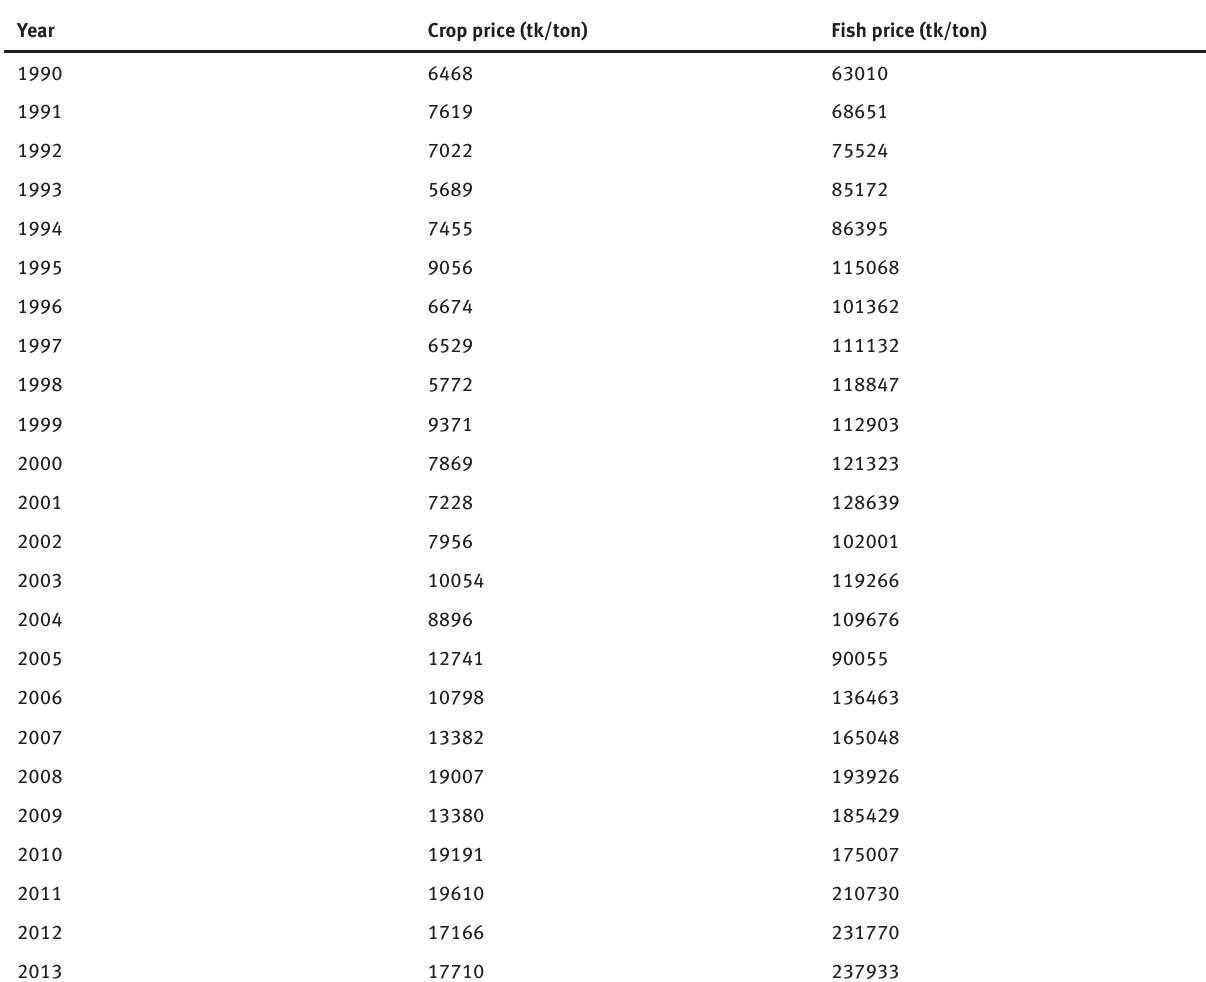
Table 1: Yearly price of crop and fish in Bangladesh